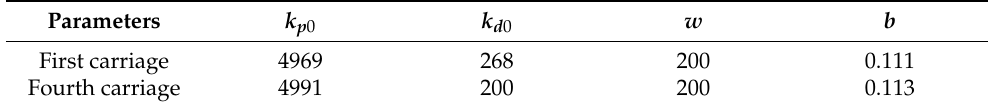
Table 3. Controller parameters of ALADRC and LADRC.